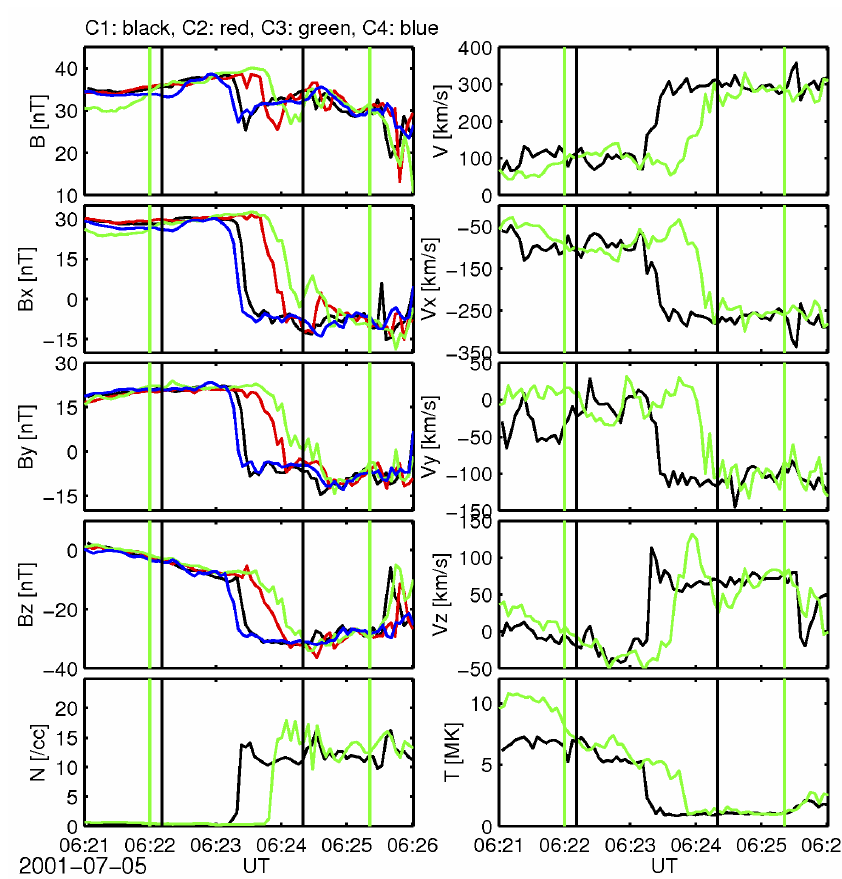
Fig. 2. Time series of Cluster measurements around, and during, a magnetopause crossing on 5 July 2001. The color code is: black=C1; red=C2; green=C3; blue=C4. The left (right) panels show magnetic field (ion velocity) and ion density (temperature), with vector components along the GSE coordinate axes. The plasma data for C1 and C3 are from the CIS/HIA instrument. The interval between black (green) vertical lines is used in the reconstruction based on C1 (C3)